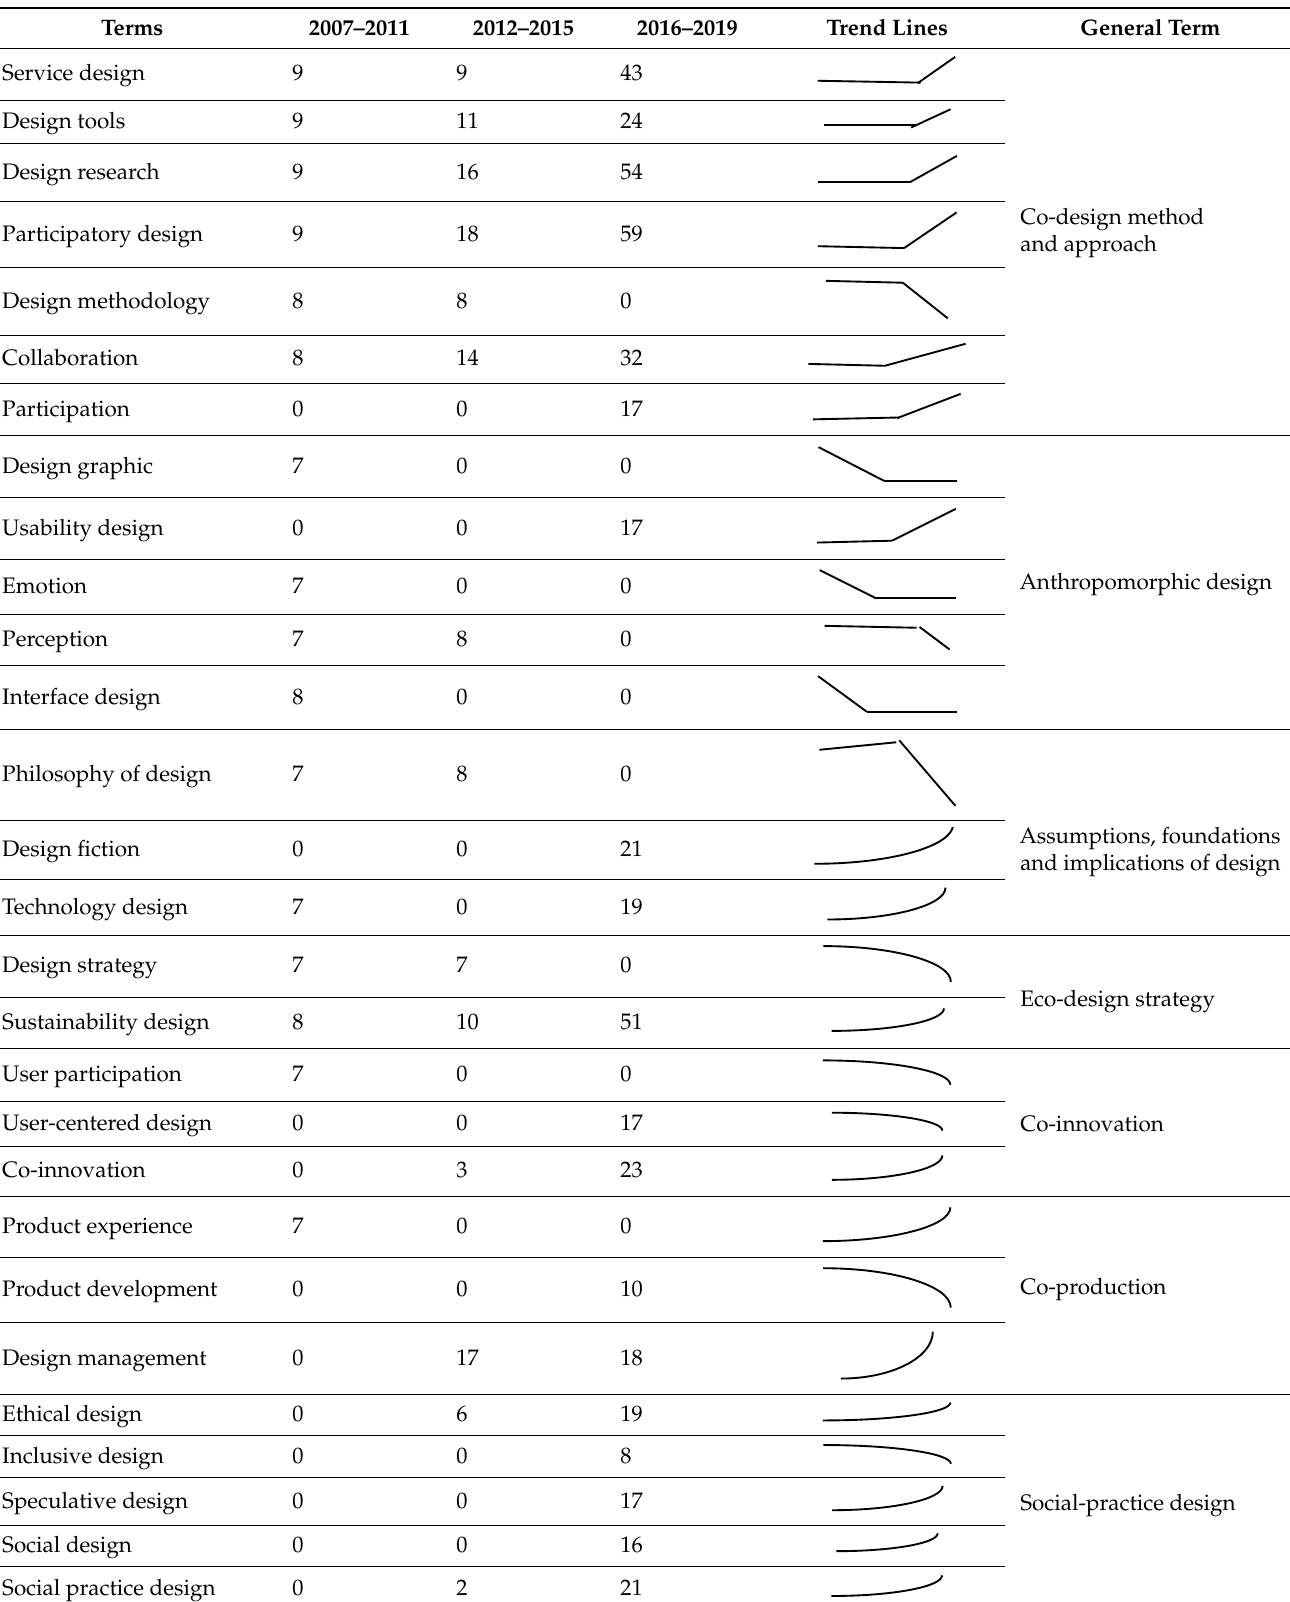
Table 4. General terms and their corresponding frequencies.